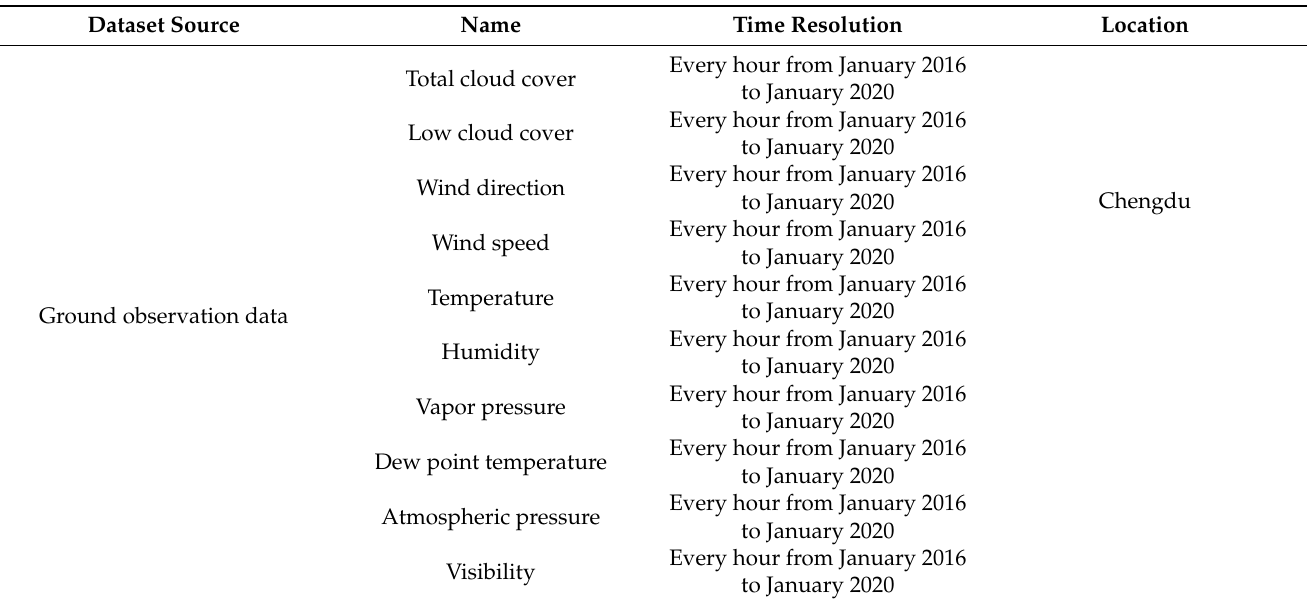
Table 1. The size of the